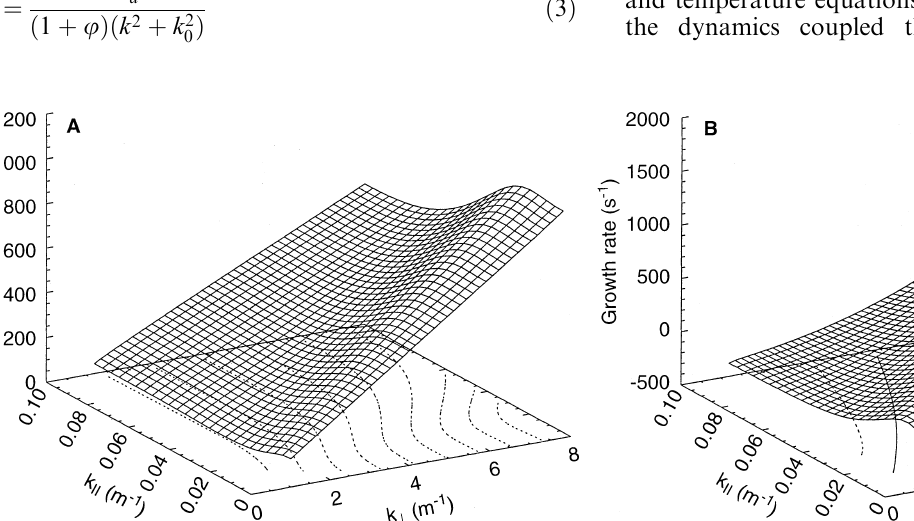
Fig. 1A, B. Numerically obtained dispersion relation for the Farley- Buneman instability. A The real part of the frequency; B the imaginary part, as functions of wave vector k with components k B and E (cid:2) B , respectively. Parameters are 6 : 10 10 m (cid:255) 3 for density, 450